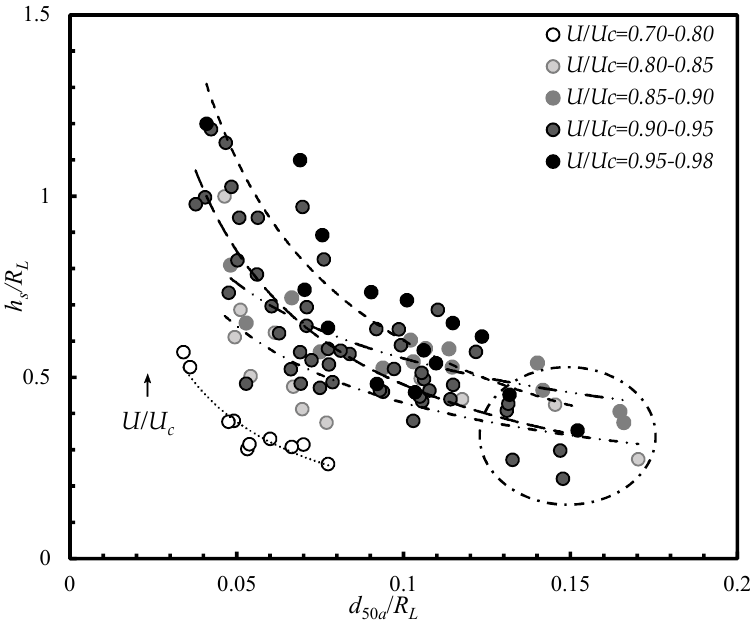
/ R L ) variation with d 50 a